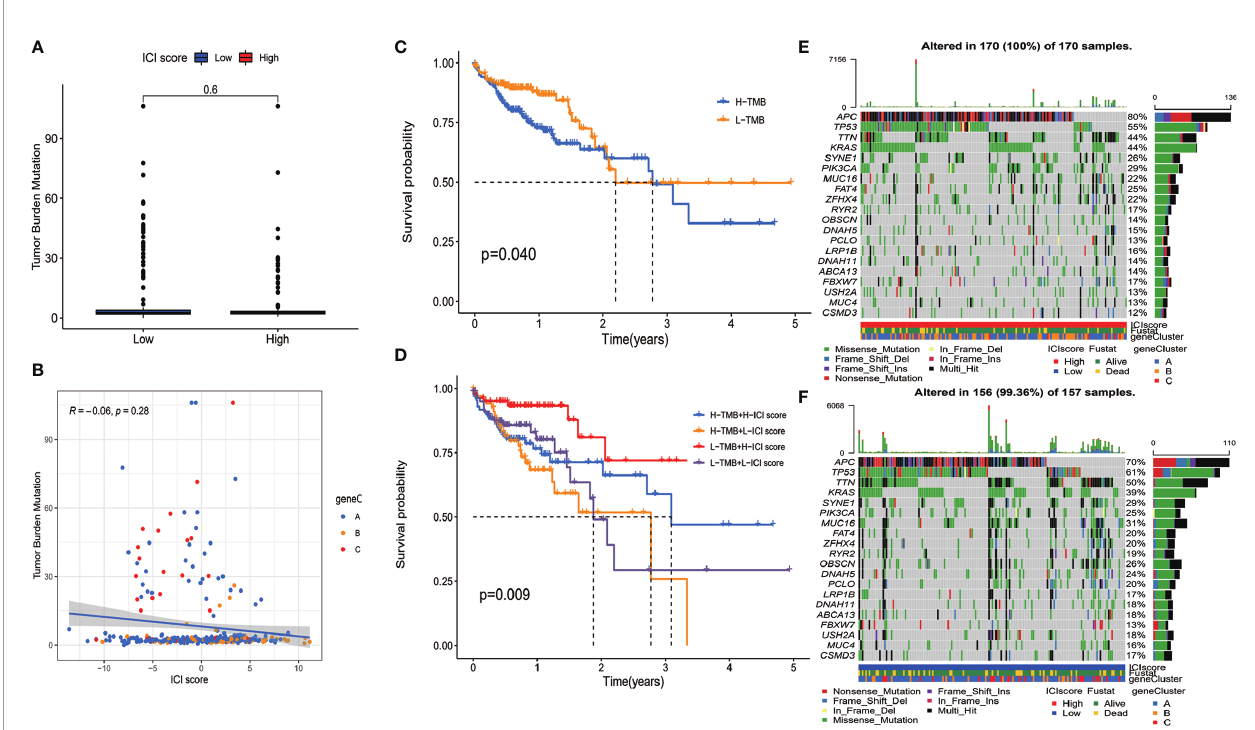
FIGURE 4 | The relationship between immune cell in fi ltration (ICI) score and somatic mutation. (A) There was no signi fi cant difference on tumor mutational burden (TMB) between the two group patients. (B) Correlation analysis revealed that ICI score was not correlated with TMB. (C) Overall survival of colon cancer patients with high and low TMB (log-rank test, p = 0.040). (D) Overall survival for colon cancer patients strati fi ed by ICI score and TMB (log-rank test, p = 0.009). (E, F) The top 20 genes with the highest mutation frequency in ICI high (E) and low (F) group. Rows represent genes, and columns represent